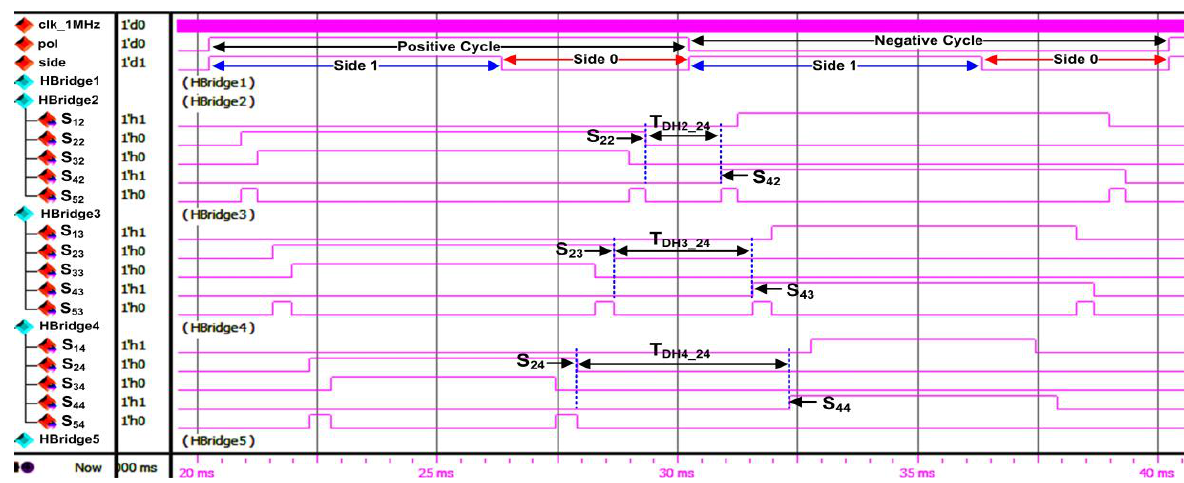
Figure 17. RTL simulation results of the SHE digital switching controller’s output gating pulses for circuits of H-Bridge 2 (S 12 –S 52 ), H-Bridge 3 (S 13 –S 53 ), and H-Bridge 4 (S 14 –S 54